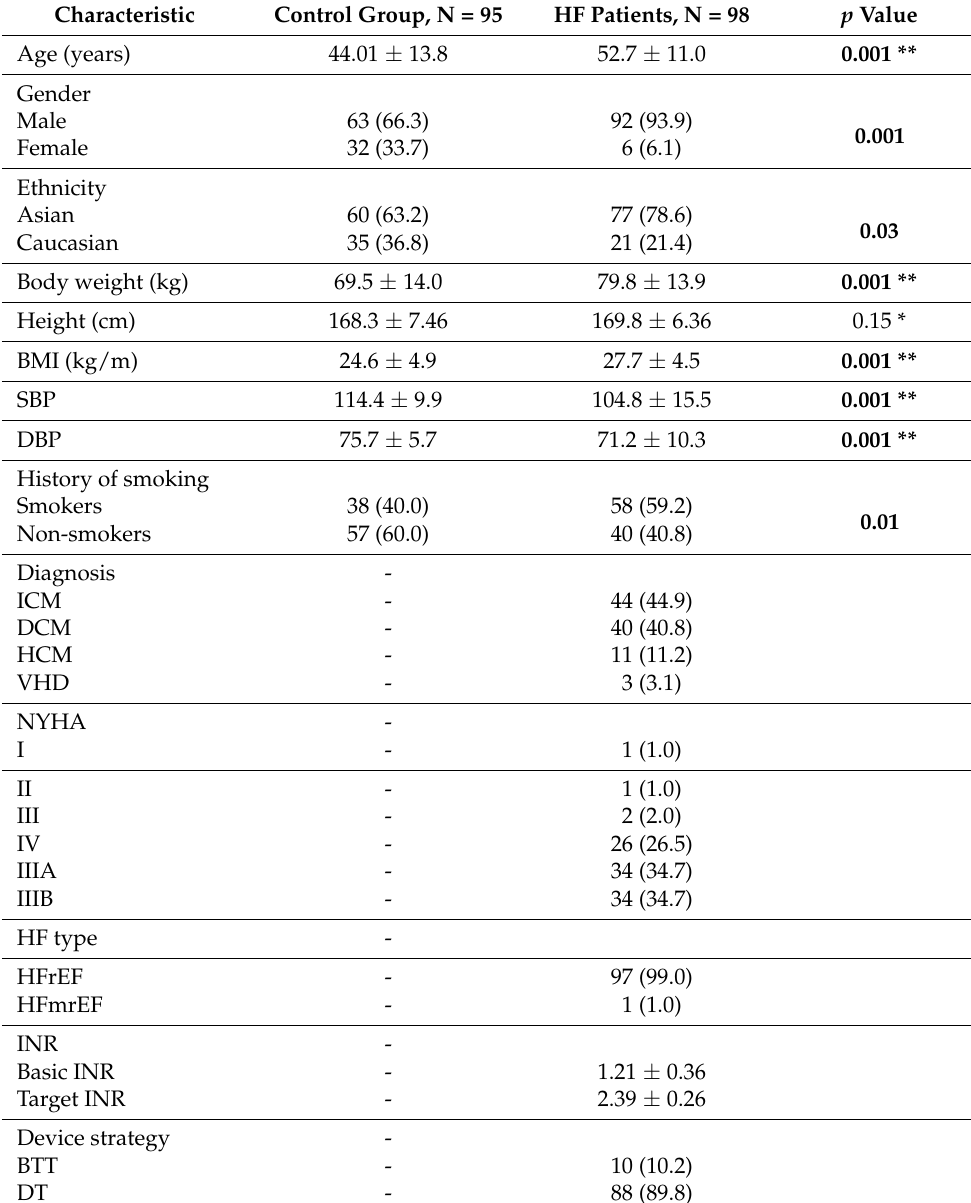
Table 1. Baseline demographic characteristics of Control group and HF